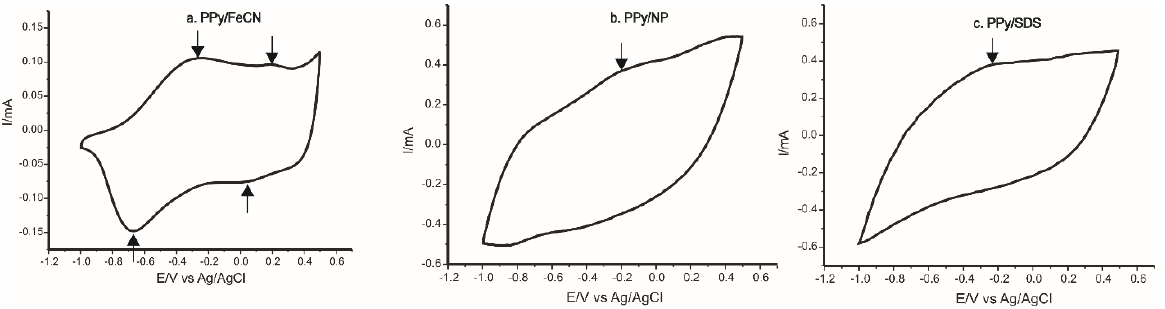
Figure 9. Stable response of polypyrrole based sensors immersed in 0.1 M KCl and 10 − 3 M L-Tyr solution at 0.1 V × s − 1 : ( a ) PPy/FeCN-SPCE, ( b ) PPy/NP-SPCE, and ( c ) PPy/SDS-SPCE.